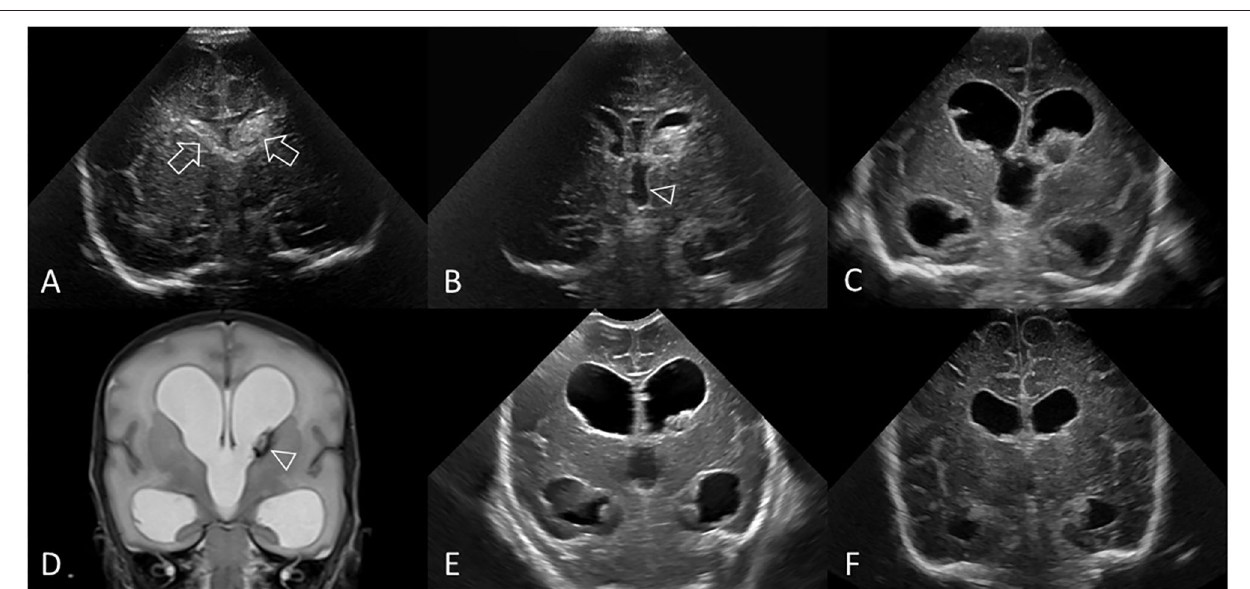
FIGURE 10 | Post-hemorrhagic ventricular dilatation. Ultrasound scan in a preterm infant (GA 30 weeks) showing bilateral GMH-IVH. (A) Coronal scan 3 days after birth shows the bilateral hemorrhages (arrows). No PVHI. (B) Coronal scan at 8 days shows both lateral ventricles are beginning to dilate and also shows dilatation of the third ventricle (arrowhead). Right AHW < 3mm and left AHW = 4mm (measurements not shown). (C) Coronal scan at 2 weeks shows ballooning of the lateral ventricles with bilateral AHW > 6mm (measurements not shown) and development of echogenic ependyma. Early clot regression. (D) Coronal T2-weighted MR image at 3 weeks shows persistent PHVD and small hypointense lesion at left caudothalamic notch representing hemosiderin staining (arrowhead). Note the absence of extracerebral CSF spaces. No PVHI. (E) Coronal scan at 4 weeks shows unchanged size of both dilated lateral ventricular bodies and temporal horns. Further regression of residual intraventricular clot. (F) Coronal scan at 10 weeks demonstrates stabilization of the PHVD with some decrease in ventricular caliber. The third ventricle is no longer dilated. Right and left AHW = 10mm (measurements not shown). However, without dilated subarachnoid spaces or PVHI, the persistent enlarged lateral ventricles indicate continued presence of PHVD rather than passive enlargement from tissue volume loss. No surgical intervention. In this example, the frontal horn ballooning and largest size of the lateral ventricles was measured on the 2 week cUS exam (right AHW = 17mm and left AHW = 15mm, panel (C) , measurements not